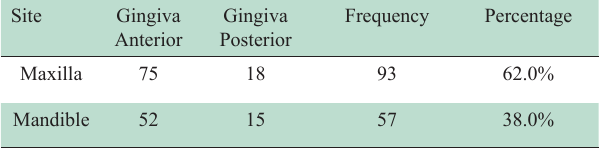
Table-II: Frequency distribution of cases according to Site (n= 150).